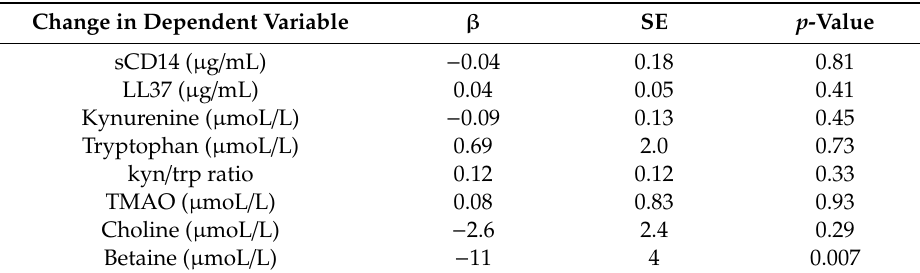
Table 3. Differences in outcomes between placebo and treatment arm.